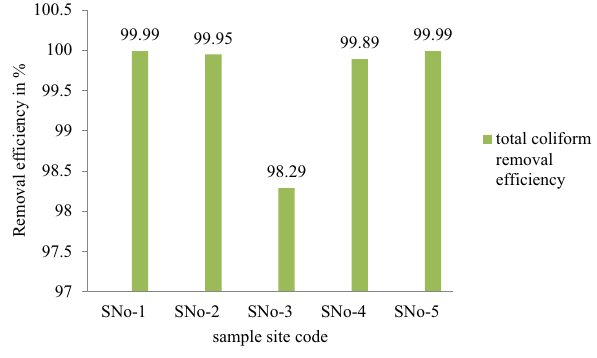
Fig. 4 The total coliform removal efficiency of chlorination from, water